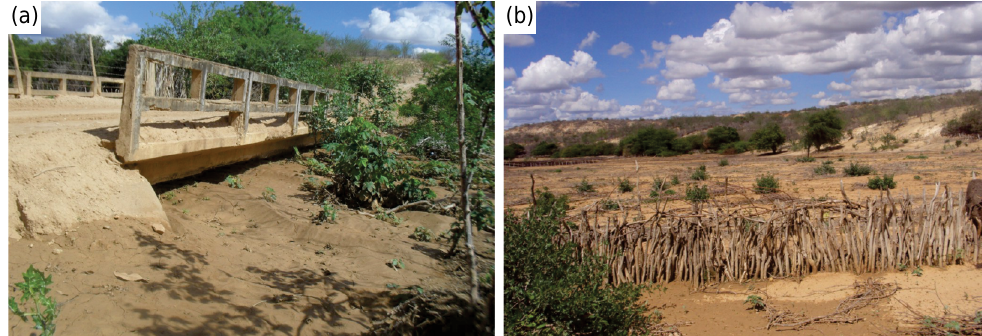
Figure 8. Sediment accumulation along the drainage line of the Salitre River (dry bed). The sediment accumulation reduced the depth of the riverbed, causing the bottom of the channel to come close to the base of the bridge (UTM – Zone-24L 307920E 8862549N) (a). Photograph of the area beside the bridge